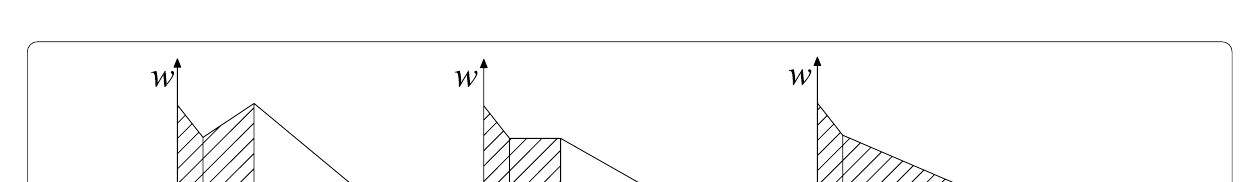
Table 6 Comparison between the experimental h parameters h , a